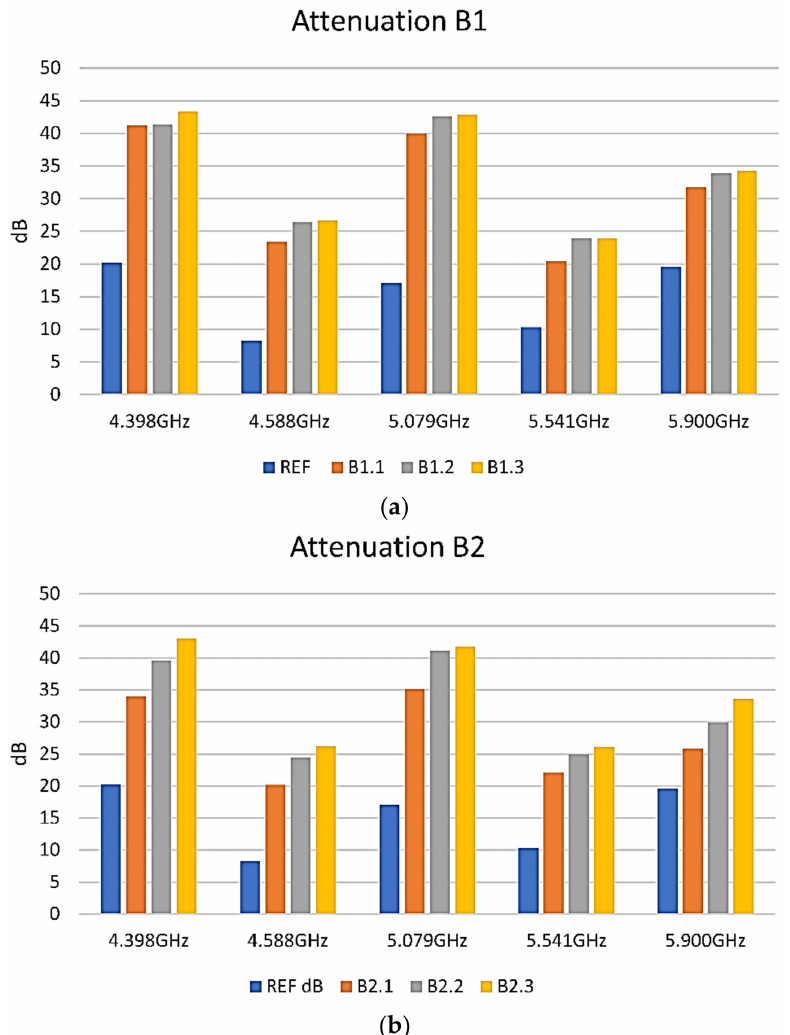
Figure 10. EMI-shielding measurements on B formulations samples. Blue reference, orange 1 layer, grey 2 layers, yellow 3 layers. ( a ) Graphic representation of EMI-shielding measurements results on B1 sample; ( b ) Graphic representation of EMI-shielding measurements results on B2